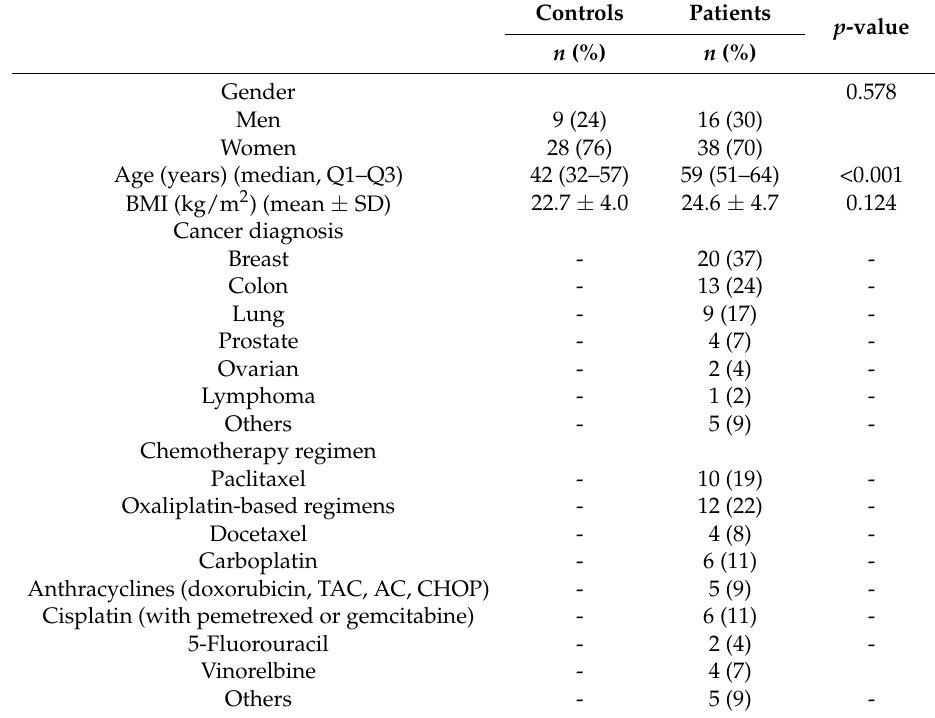
Table 1. Characteristics of the